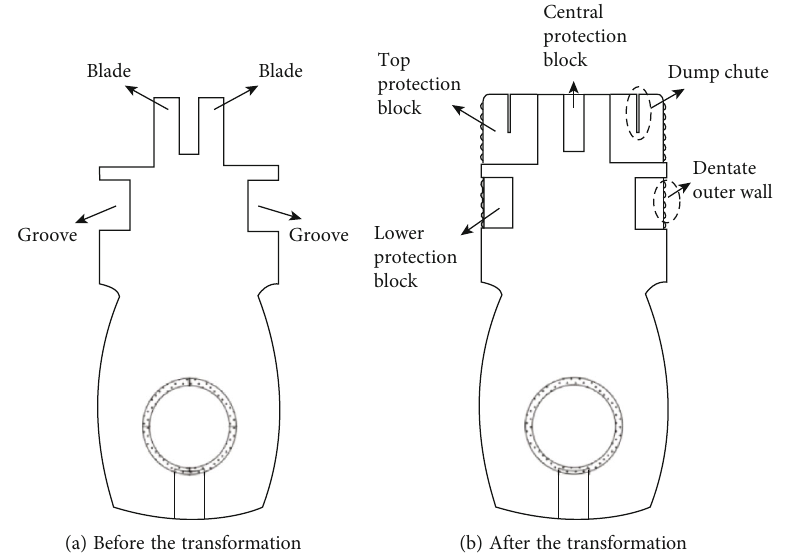
Figure 9: The transformation of the shield tearing